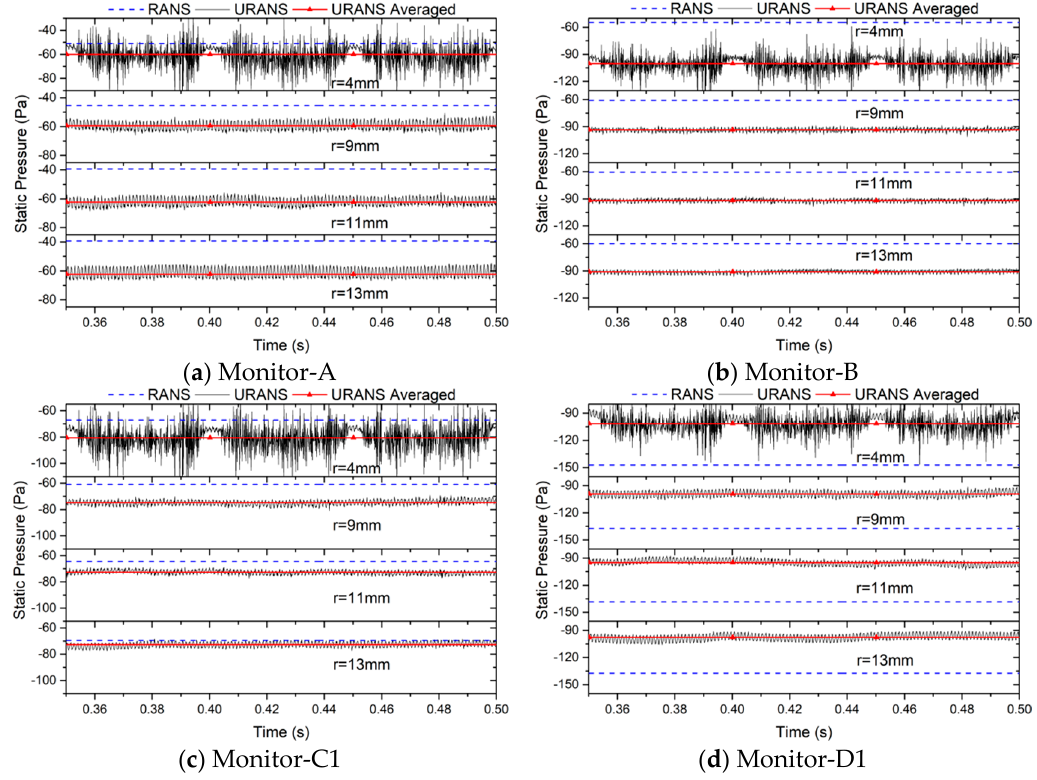
Figure 19. Static pressure fluctuation at monitors A/B/C1/D1.